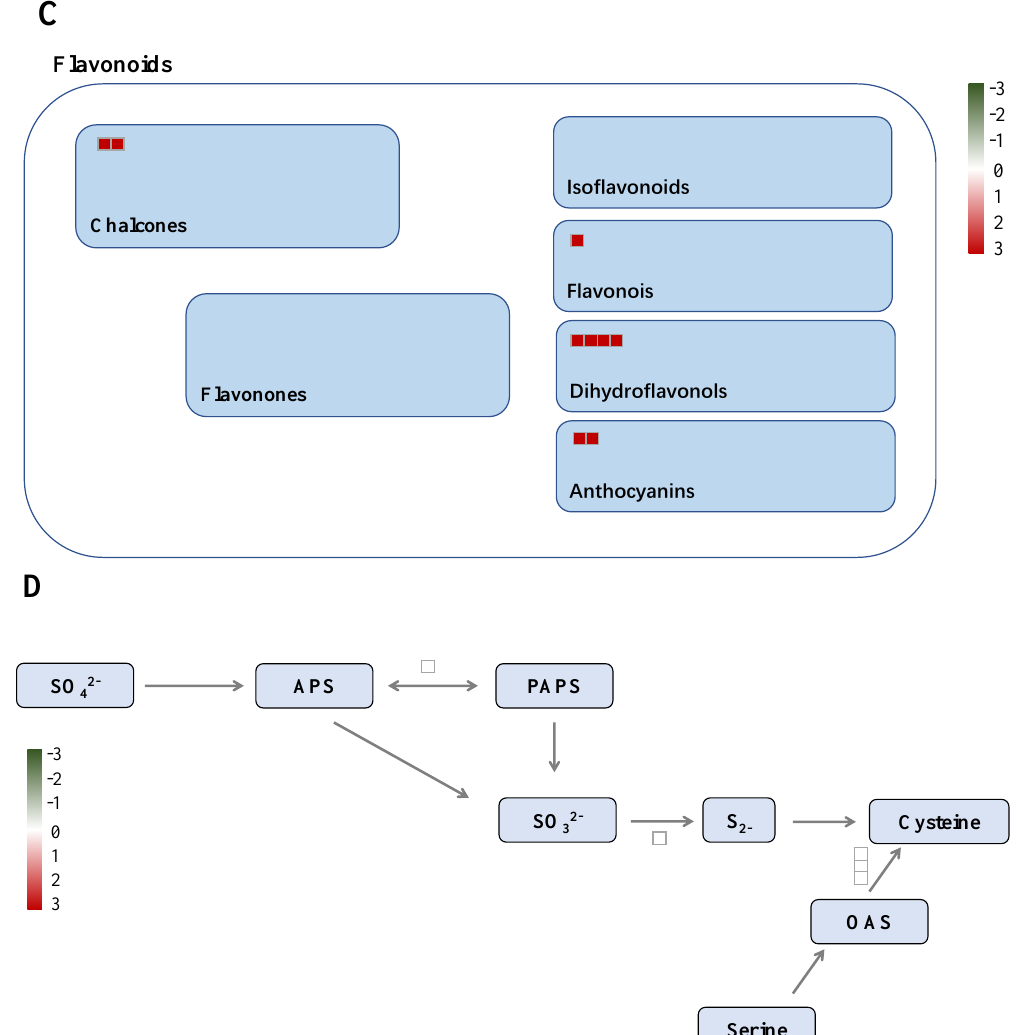
Figure11. Overviewsoftetrapyrrolesynthesis( A , B ),flavonoidsmetabolism( C ),andsulfatemetabolism ( D ) of the DAPs. Panels ( A ) and ( B ) indicate tetrapyrrole synthesis enriched in Atlas 66 and Scout 66, respectively; Panels ( C ) and ( D ) represent the enriched pathways of flavonoids metabolism in Atlas 66 and of sulfate metabolism in Scout 66; all of them were analyzed in and exported from MapMan software and the image quality was further improved